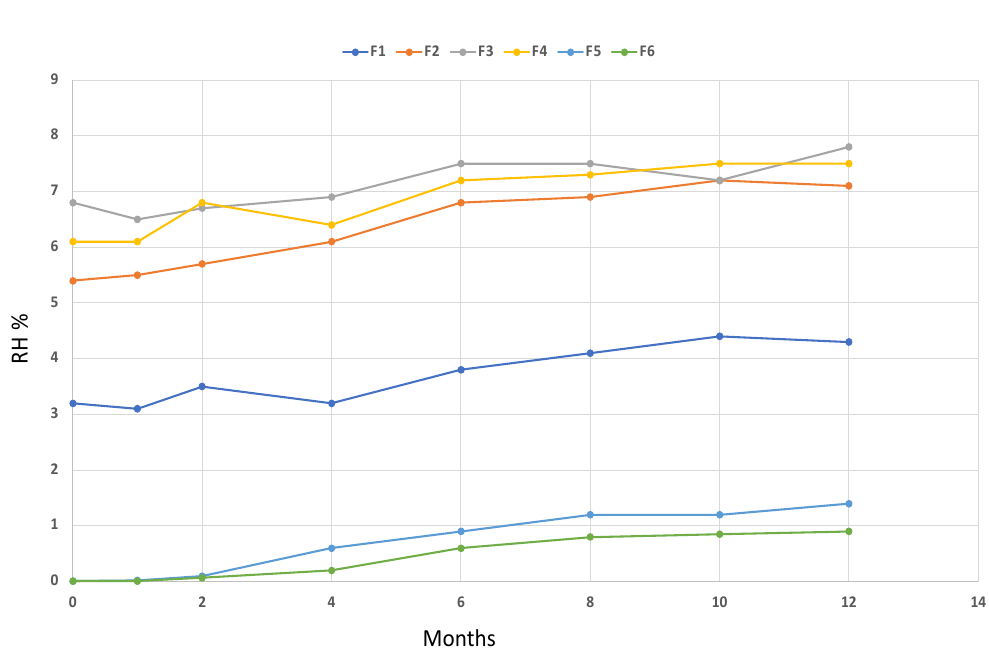
Figure 2. Monitoring of the RH over a period of 12 months for formulation 1 (F1, blue), formulation 2 (F2, orange), formulation 3 (F3, grey), formulation 4 (F4, yellow), formulation 5 (F5, light blue), and formulation 6 (F6, green).